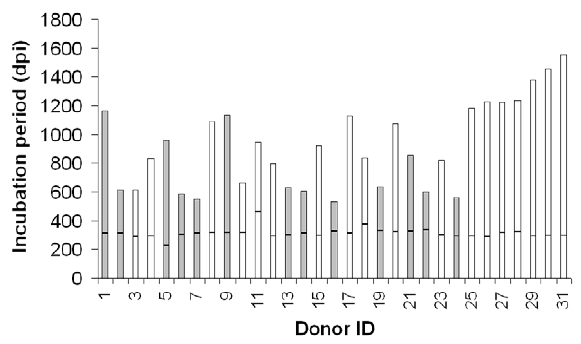
Figure 2. Varied incubation times are seen in blood donors following oral inoculation with BSE. All BSE-infected donor sheep (apart from donor 4, which was culled for welfare reasons) were culled on demonstration of clinical signs. The range of incubation period for sheep confirmed as having BSE is 534–1544 days post infection (dpi). The horizontal bar in each column represents the time of blood collection for separation and subsequent transfusion to recipients and ranges from 228–463 days post oral inoculation. To date, 31/39 donors have succumbed to BSE infection and the grey bars indicate donor blood, which when transfused, caused disease in recipients.